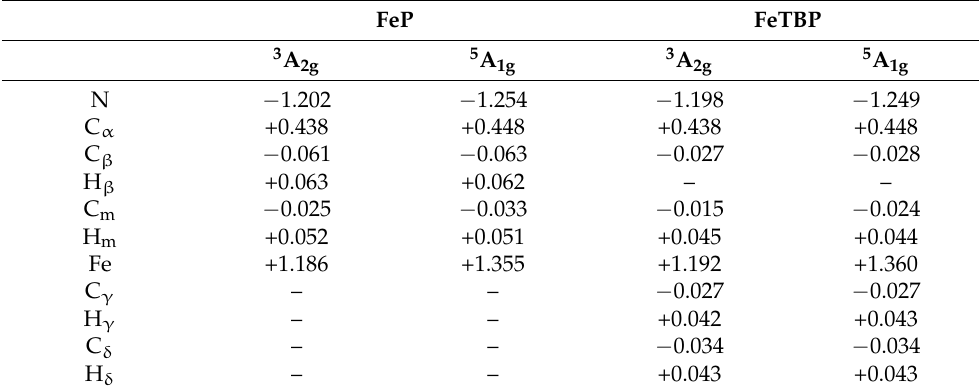
Table 3. Net atomic charges (e) by PBE0/def2-TZVP calculations.